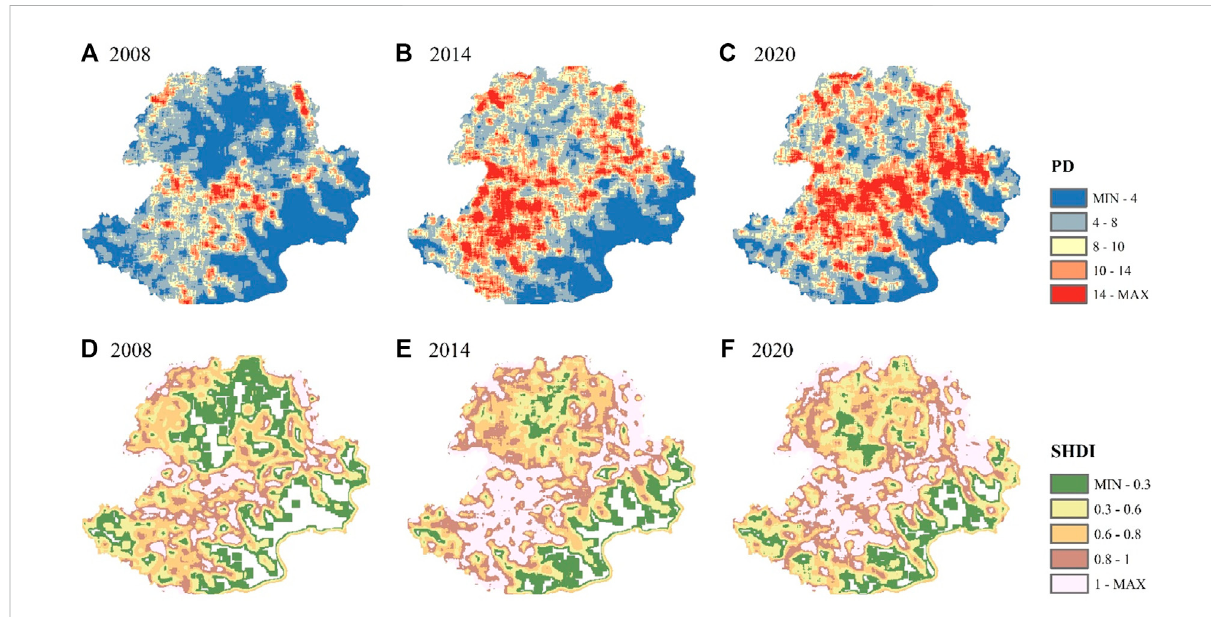
FIGURE 6 Raster map of landscape pattern in urban area of Anshan. (A) Patch density in 2008; (B) Patch density in 2014; (C) Patch density in 2020; (D) 2008 Shannon ’ s diversity index; (E) 2014 Shannon ’ s diversity Index; (F) 2020 Shannon ’ s diversity